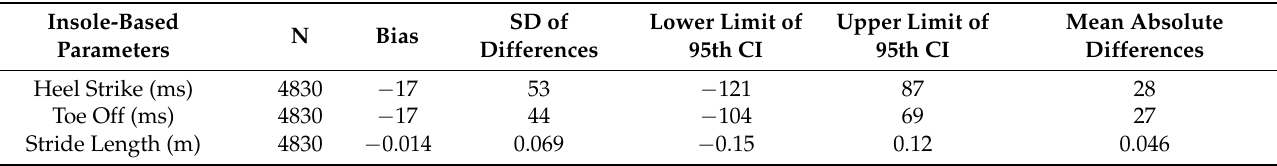
Table 1. Characterization of the differences between GAITRite ® and insoles for the insole-based parameters including HS, TO events and stride length with 4830